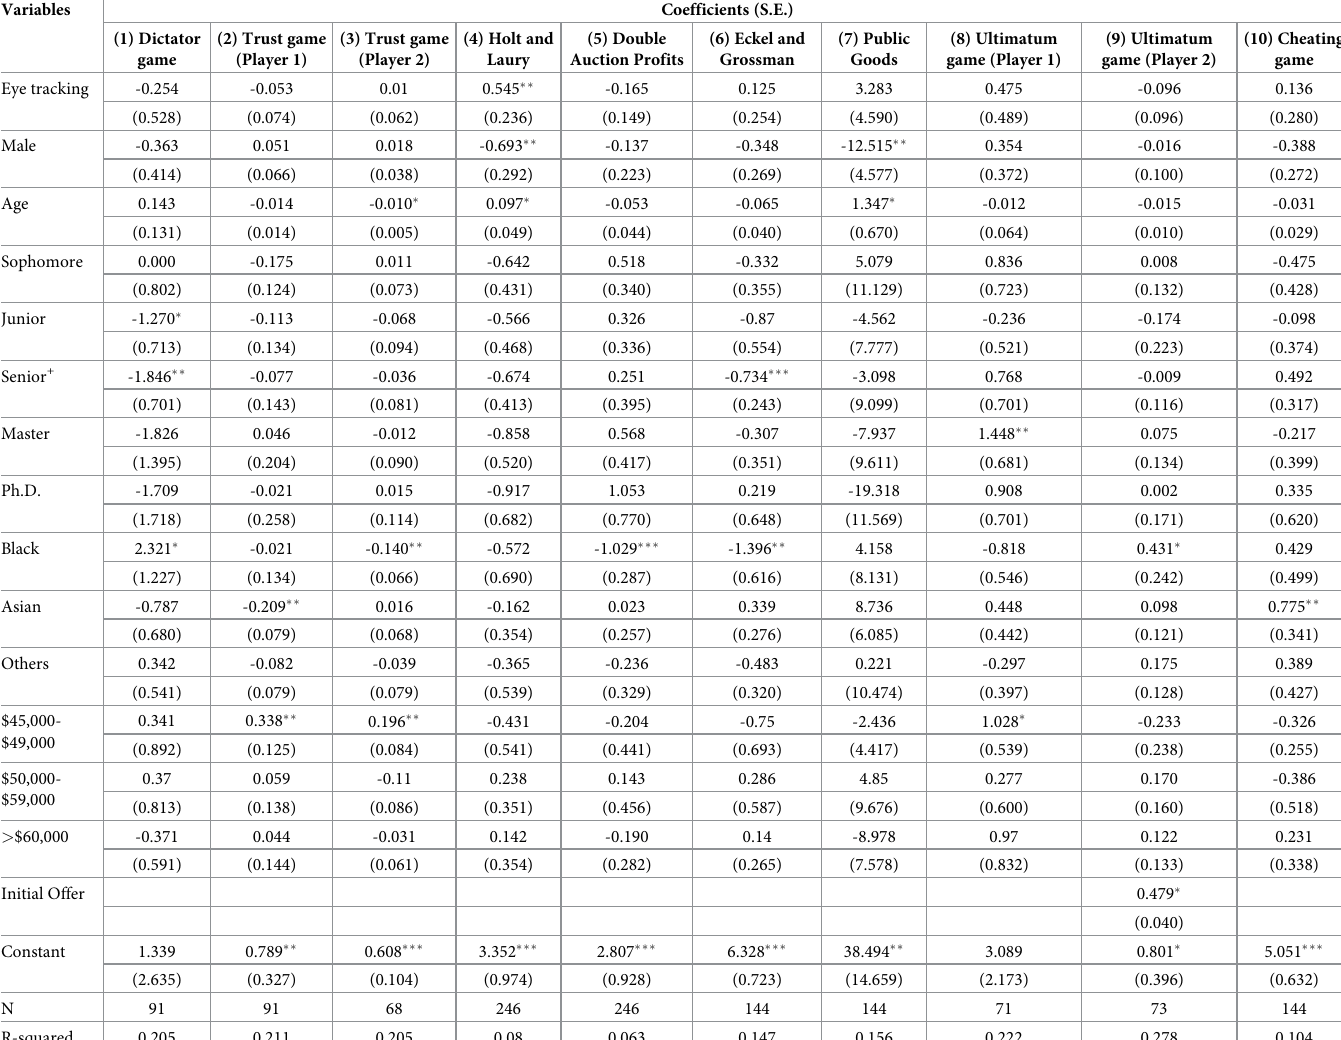
Table 3. Regression estimates for all games including demographic controls.